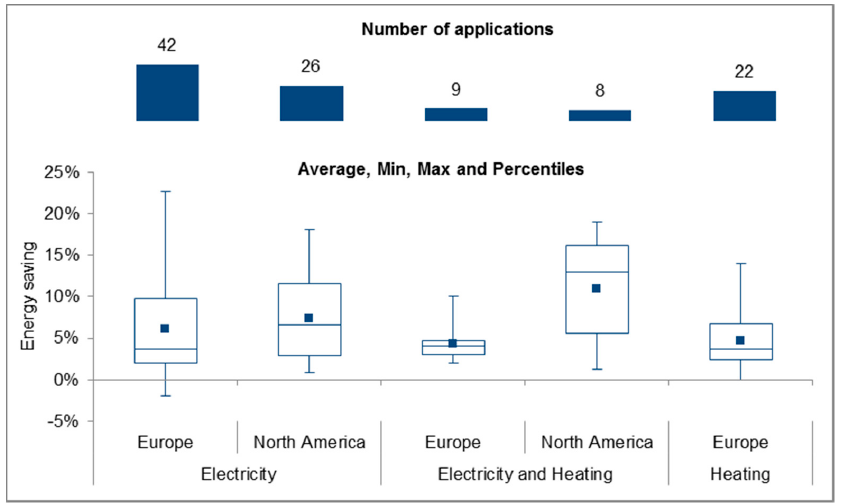
Figure 4. Number of studies and statistical analysis of energy savings, per type of energy end-use, and geographical zone (based on 107 out of 114 feedback applications).